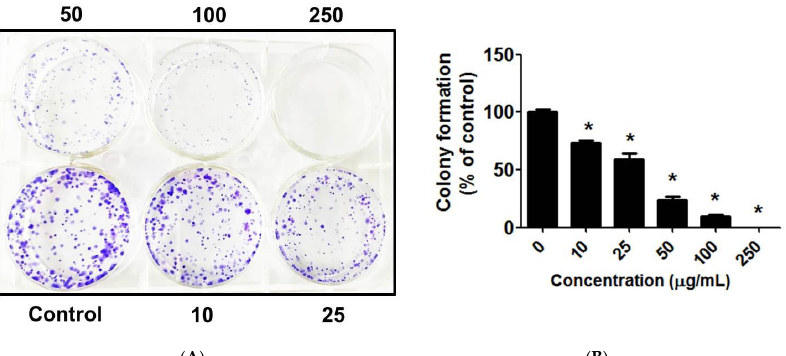
Figure 7. ( A ) Clonogenic formation of A549 cells treated with 0, 10, 25, 50, 100, and 250 µg/mL of C. chinense leaf extract, and ( B ) the percentage of colony formations of A549 cells treated with various